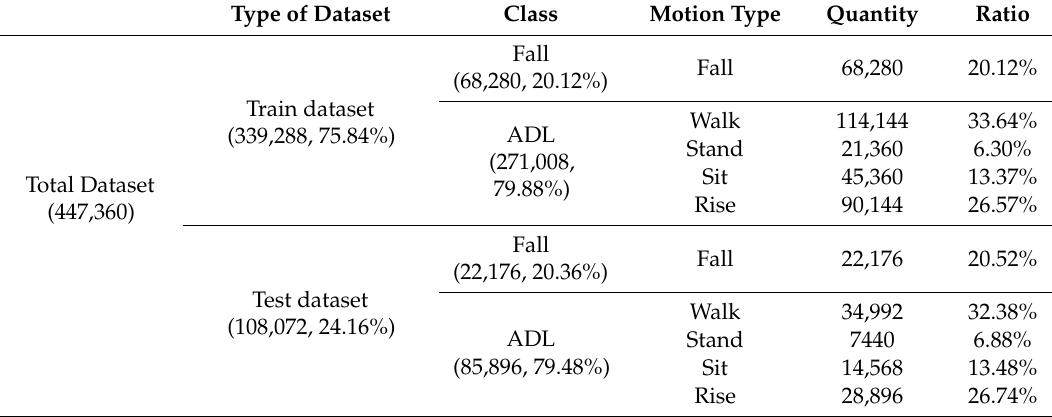
Table 7. Data configuration and class classification at the image level to create a CNN-based binary object behavior classification model.